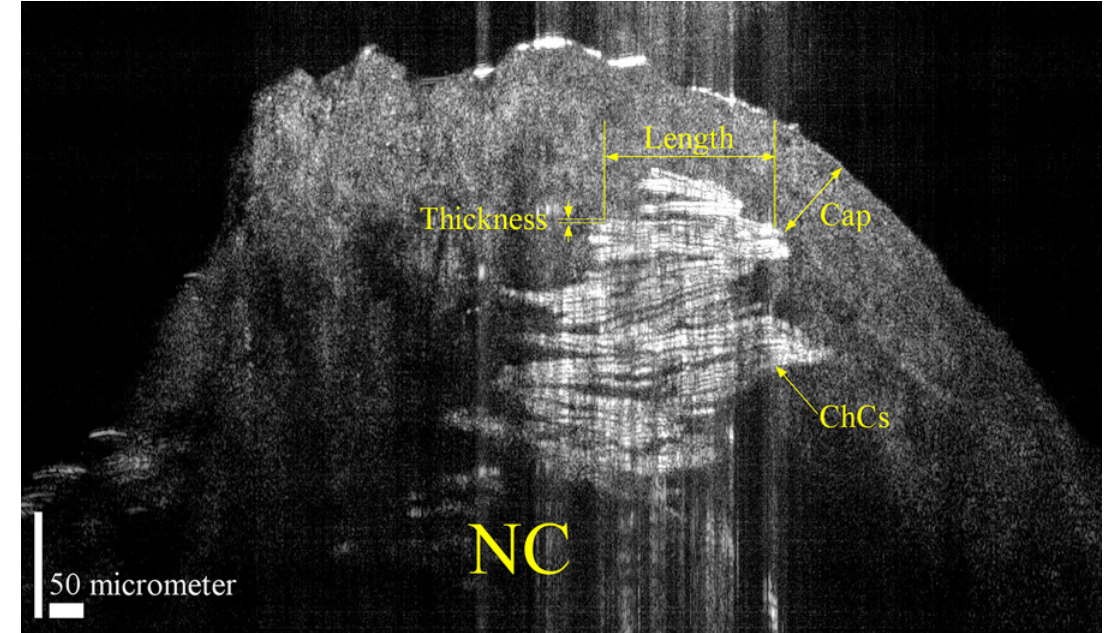
Fig 3. A μ OCT Image of a Human Aortic Atherosclerotic Plaque Revealing the Geometries of Cholesterol Crystals. ChCs: cholesterol crystals. NC: necrotic core. Scale bar, 50 μ m.